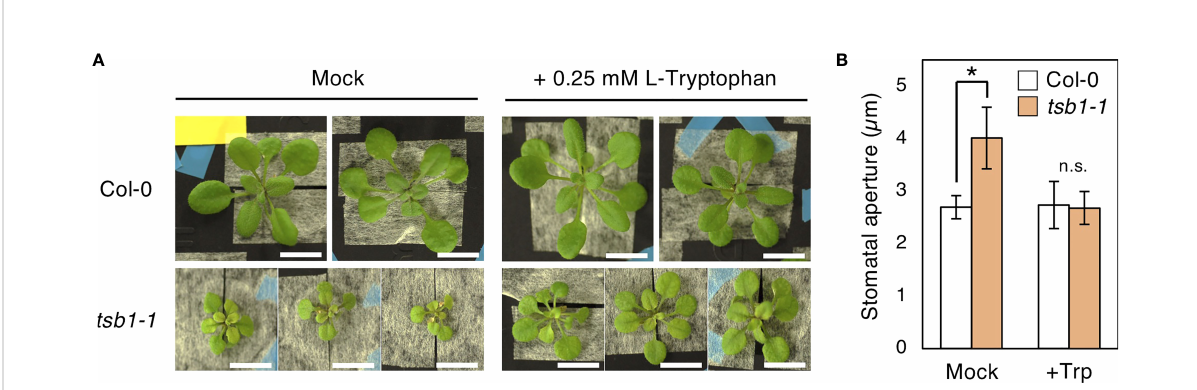
FIGURE 7 Effect of exogenous L-Trp on the phenotypes of tsb1-1 . (A) Four-week-old Col-0 and tsb1-1 plants grown with or without L-Trp. Plants were grown on MS plate for 10days and transferred to hydroponic system with or without 0.25 mM L-Trp for 2 weeks. Scale bar = 1 cm. (B) Stomatal aperture of Col-0 and tsb1-1 plants grown with or without L-Trp under illuminated growth condition. 10-day-old seedlings germinated on MS plate were transferred to hydroponic system with or without 0.25 mM L-Trp, and were grown for a further 3 to 4 weeks. Epidermal tissues were isolated at ZT4-7 and immediately subjected to measurement of stomatal aperture. Values represent mean ± SD (n = 3); measurement of > 25 stomata in each experiment. Asterisk indicates a signi fi cant statistical difference relative to Col-0 by Student t test (* P < 0.05; n.s., not signi fi